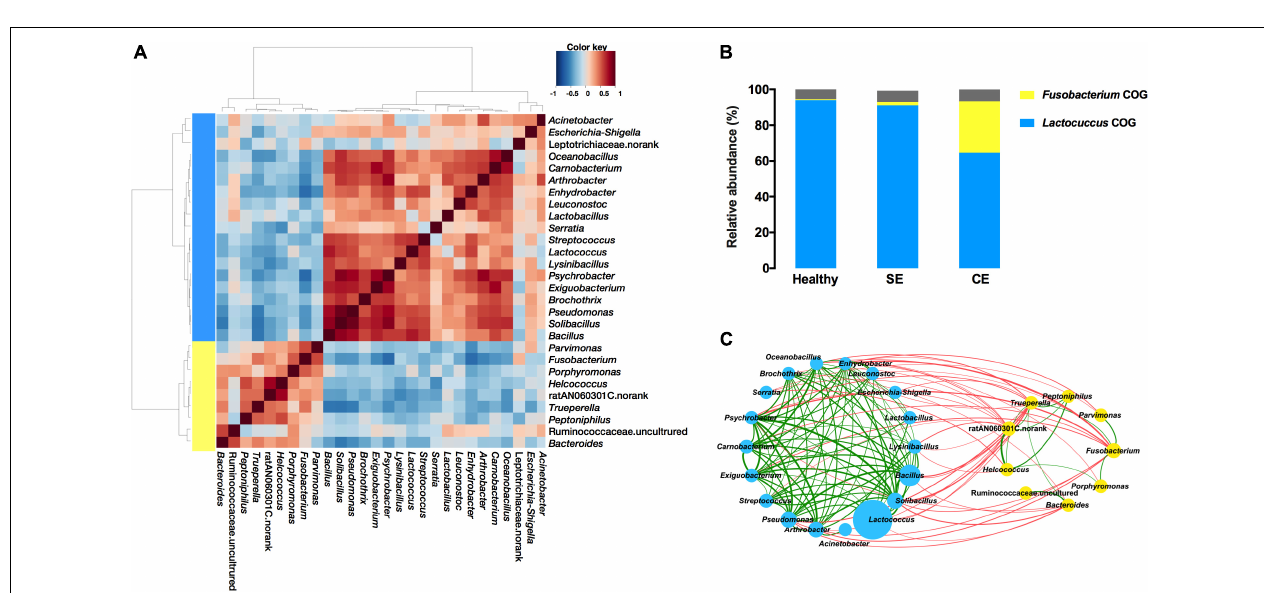
FIGURE 5 | Co-occurrence groups (COGs) assignment depended on heat plot (A) showing Spearman correlations between genera, clustered by Ward-linkage hierarchical clustering. (B) The average cumulative abundance of genera in each COG for healthy, SE and CE cows is also plotted. Colors are indicative of the two identified COGs: Lactococcus COG (blue) and Fusobacterium COG (yellow). The proportion of genera not considered in the COG assignment is colored gray. (C) The network plot showing correlations between bacterial genera in the uterine microbiota of all cows (C) . The nodes represent the genera; the circle size of each node is proportional to its average relative abundance in all samples. Blue and yellow nodes indicate genera belong to Lactococcus COG and Fusobacterium COG, respectively. The edges between nodes represent significant ( P < 0.05) correlations between genera, the thickness of edge is proportional to the correlation strength (see Supplementary Table S5 ). Green and red edges indicate positive and negative correlations, respectively. Healthy, healthy cows, n = 13; SE, subclinical endometritic cows, n = 5; CE, clinical endometritic cows, n = 9.